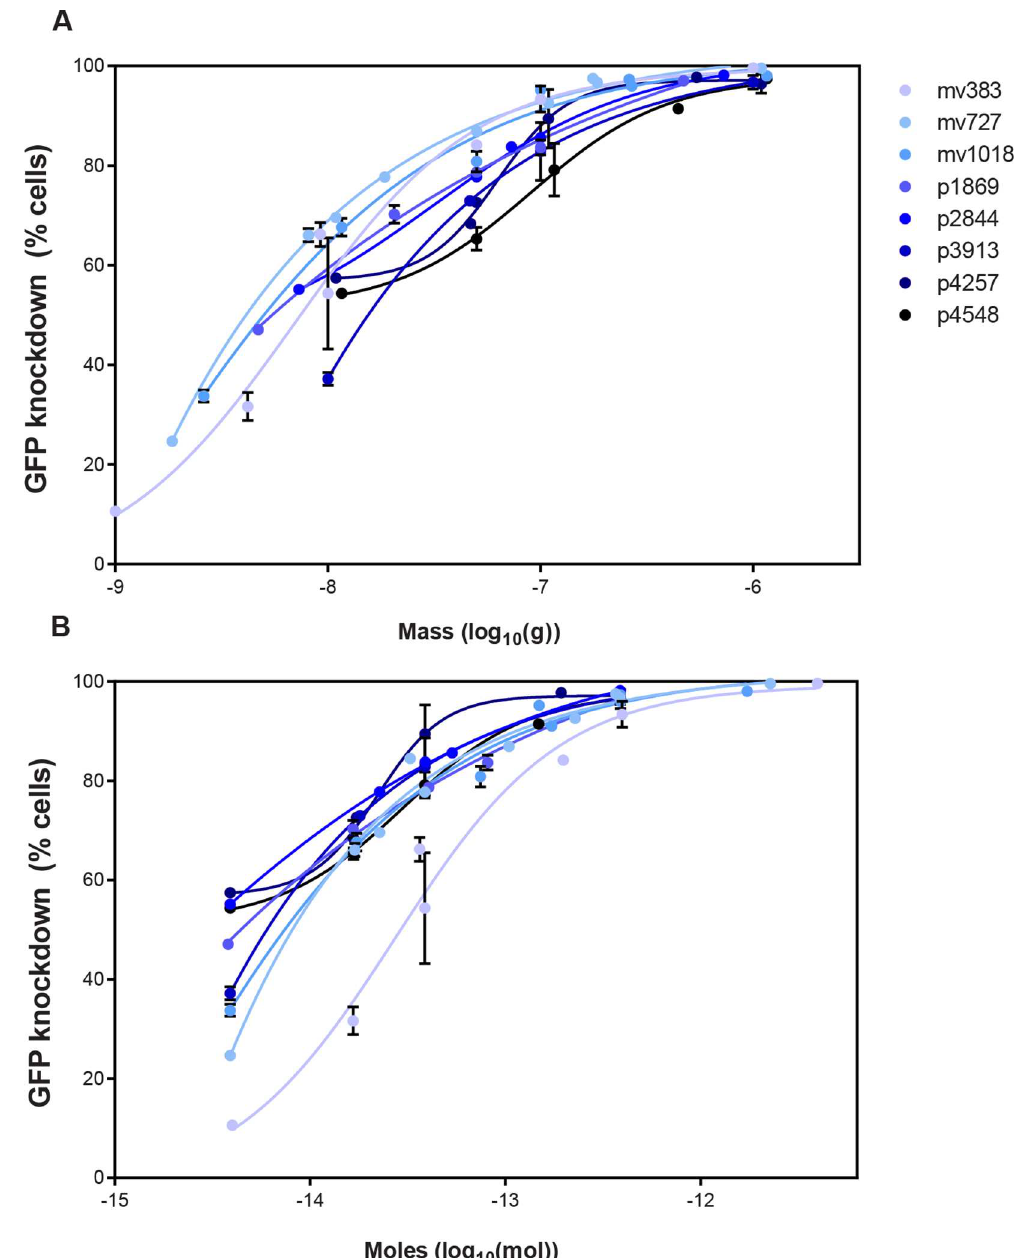
Fig 7. Effect of GFP knockdown as a function of DNA concentration. GFP knockdown was measuredusing a variety of DNA concentrations for each of the eight DNA vectors. Cells were analyzedusing flow cytometry 48 hours post-transfection. The data were plotted either comparing the mass (A) or the number of molecules(B) of each of the different DNA vector lengths. Each panelshows the percentage of cells where GFP has been knocked down relative to the “no DNA”